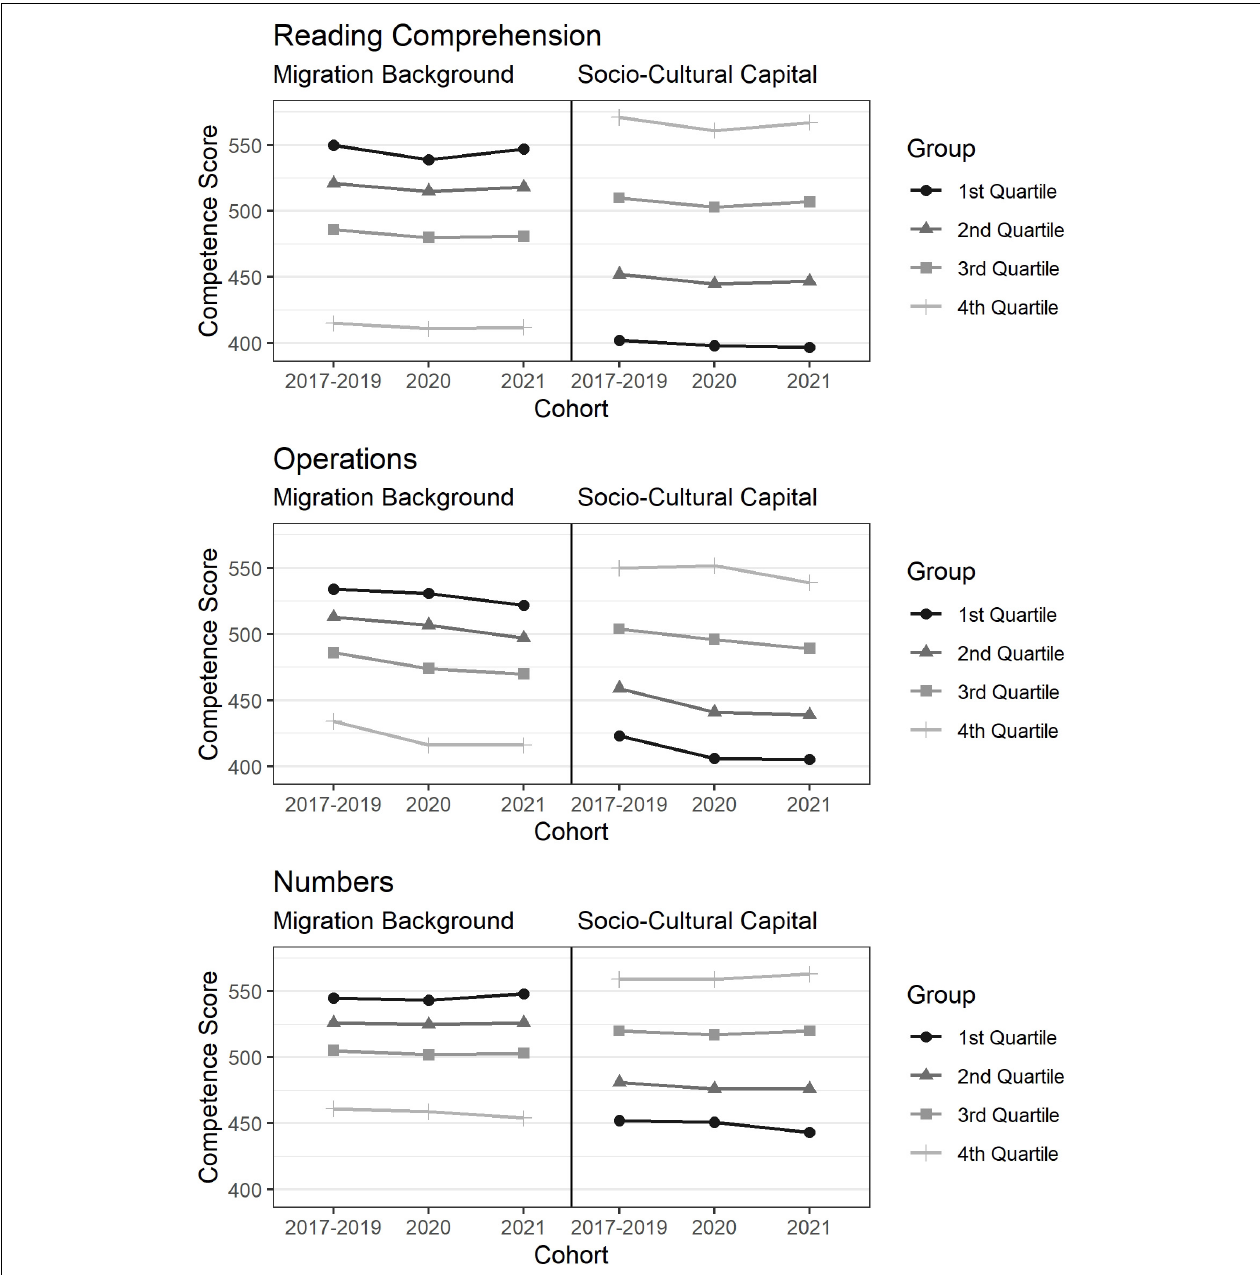
FIGURE 3 | Average School Scores for Each Quartile of the Proportion of Students With Migration Background (Left) and for Each Quartile of the Schools’ Average Socio-Cultural Capital (i.e., Number of Books at Home; Right). Means were weighted by school size.